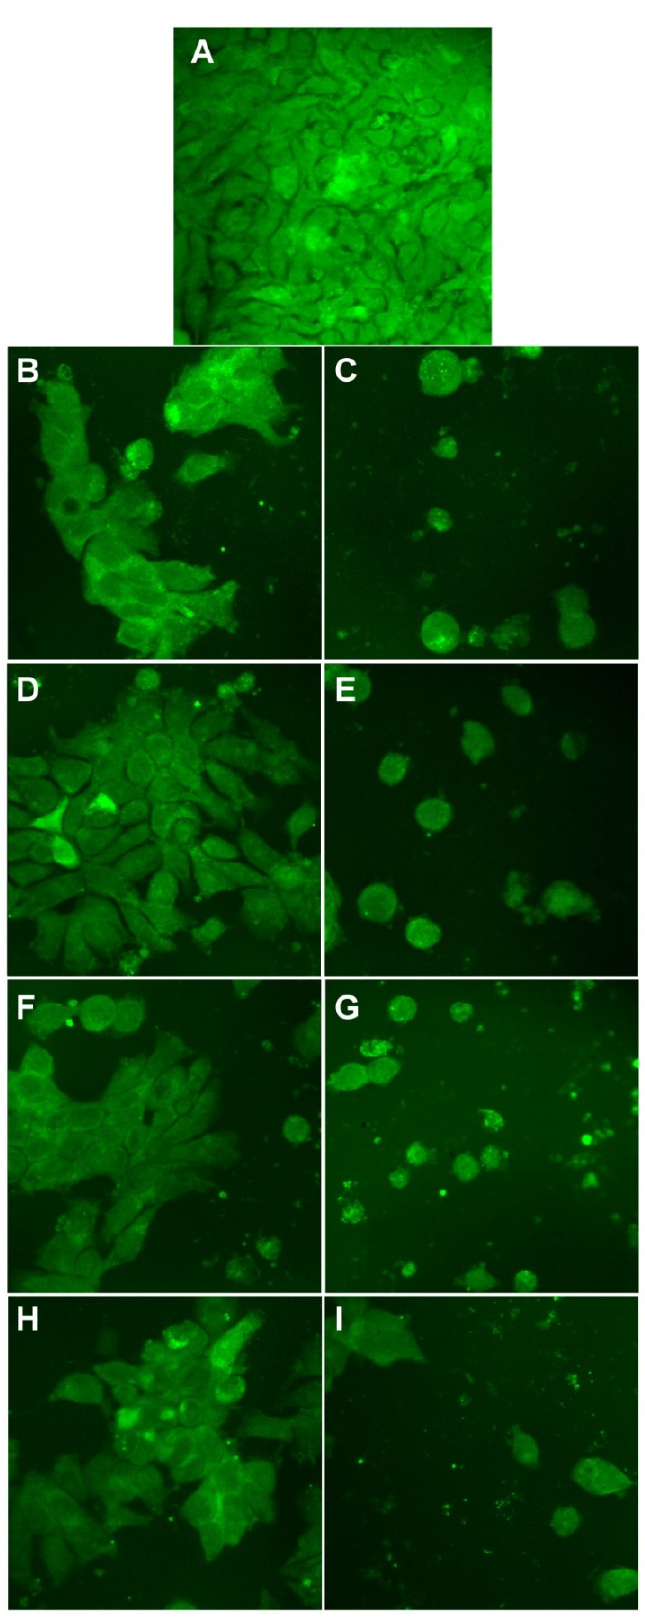
Figure 14. Morphological evaluation of HT-29 cells treated with Tur-nAg/AgCl ( B , C ), Tur-nAg/AgCl–Lip ( D , E ), Tur-nAg/AgCl–CTS ( F , G ), and Tur-nAg/AgCl–Lip–CTS ( H , I ) at two different concentrations: 12.8 mg/mL and 51.1 mg/mL, respectively, compared with control cells ( A ).